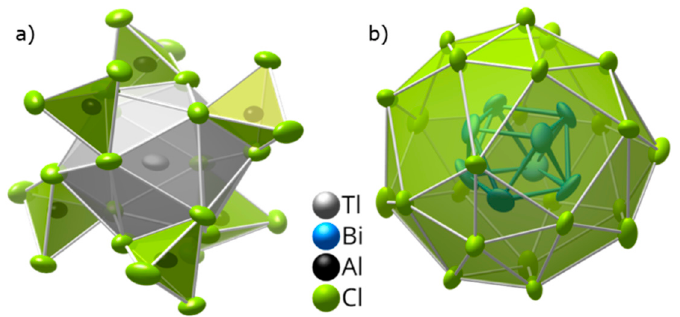
Figure 2. Coordination polyhedra in (Bi 8 )Tl[AlCl 4 ] 3 : ( a ) distorted [TlCl 12 ] 11 − icosahedron built from six [AlCl 4 ] − tetrahedra; ( b ) distorted snub cube of 24 chloride ions around a Bi 82+ polycation. (point symmetry 6). This site symmetry does not comply with the D 4d symmetry of a square